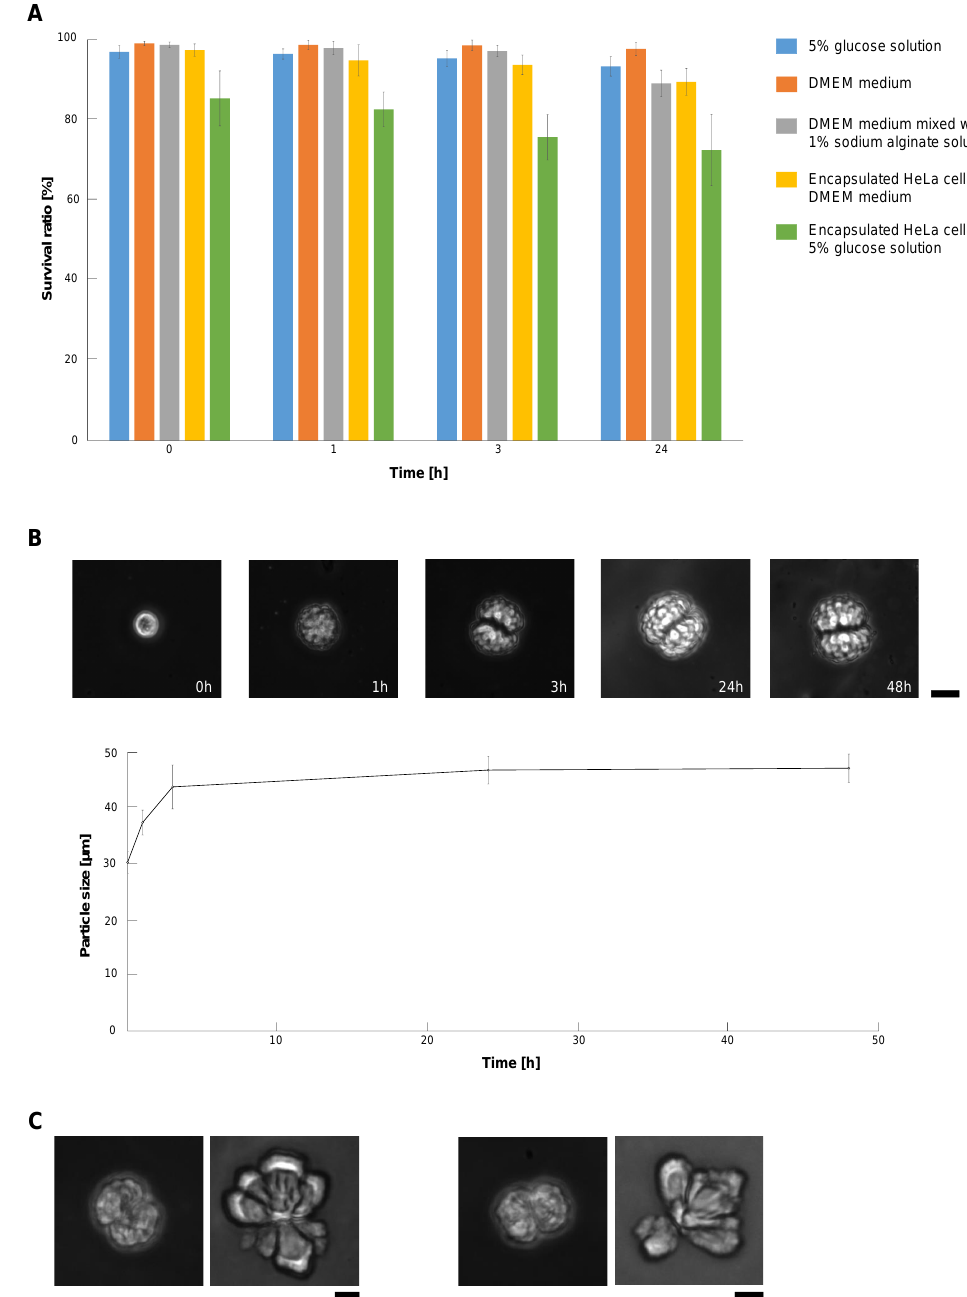
Figure 6. Survival ratio and growth of HeLa cells in alginate microcapsules. ( A ). Comparison of survival ratio of HeLa cells in DMEM medium and 5% glucose solution with (n = 3)/without (n = 5) alginate encapsulation. ( B ). Size increase of HeLa cell-encapsulated alginate microcapsules during cultivation (n = 3). Upper images are examples of cultivating microcapsules. Bar, 20µm. ( C ). Encapsulated cells were released by exchanging calcium alginate gel for alginate sol in EDTA buffer. Left: Encapsulated HeLa cell in DMEM medium, Right: Encapsulated HeLa cell in EDTA buffer. Bar,